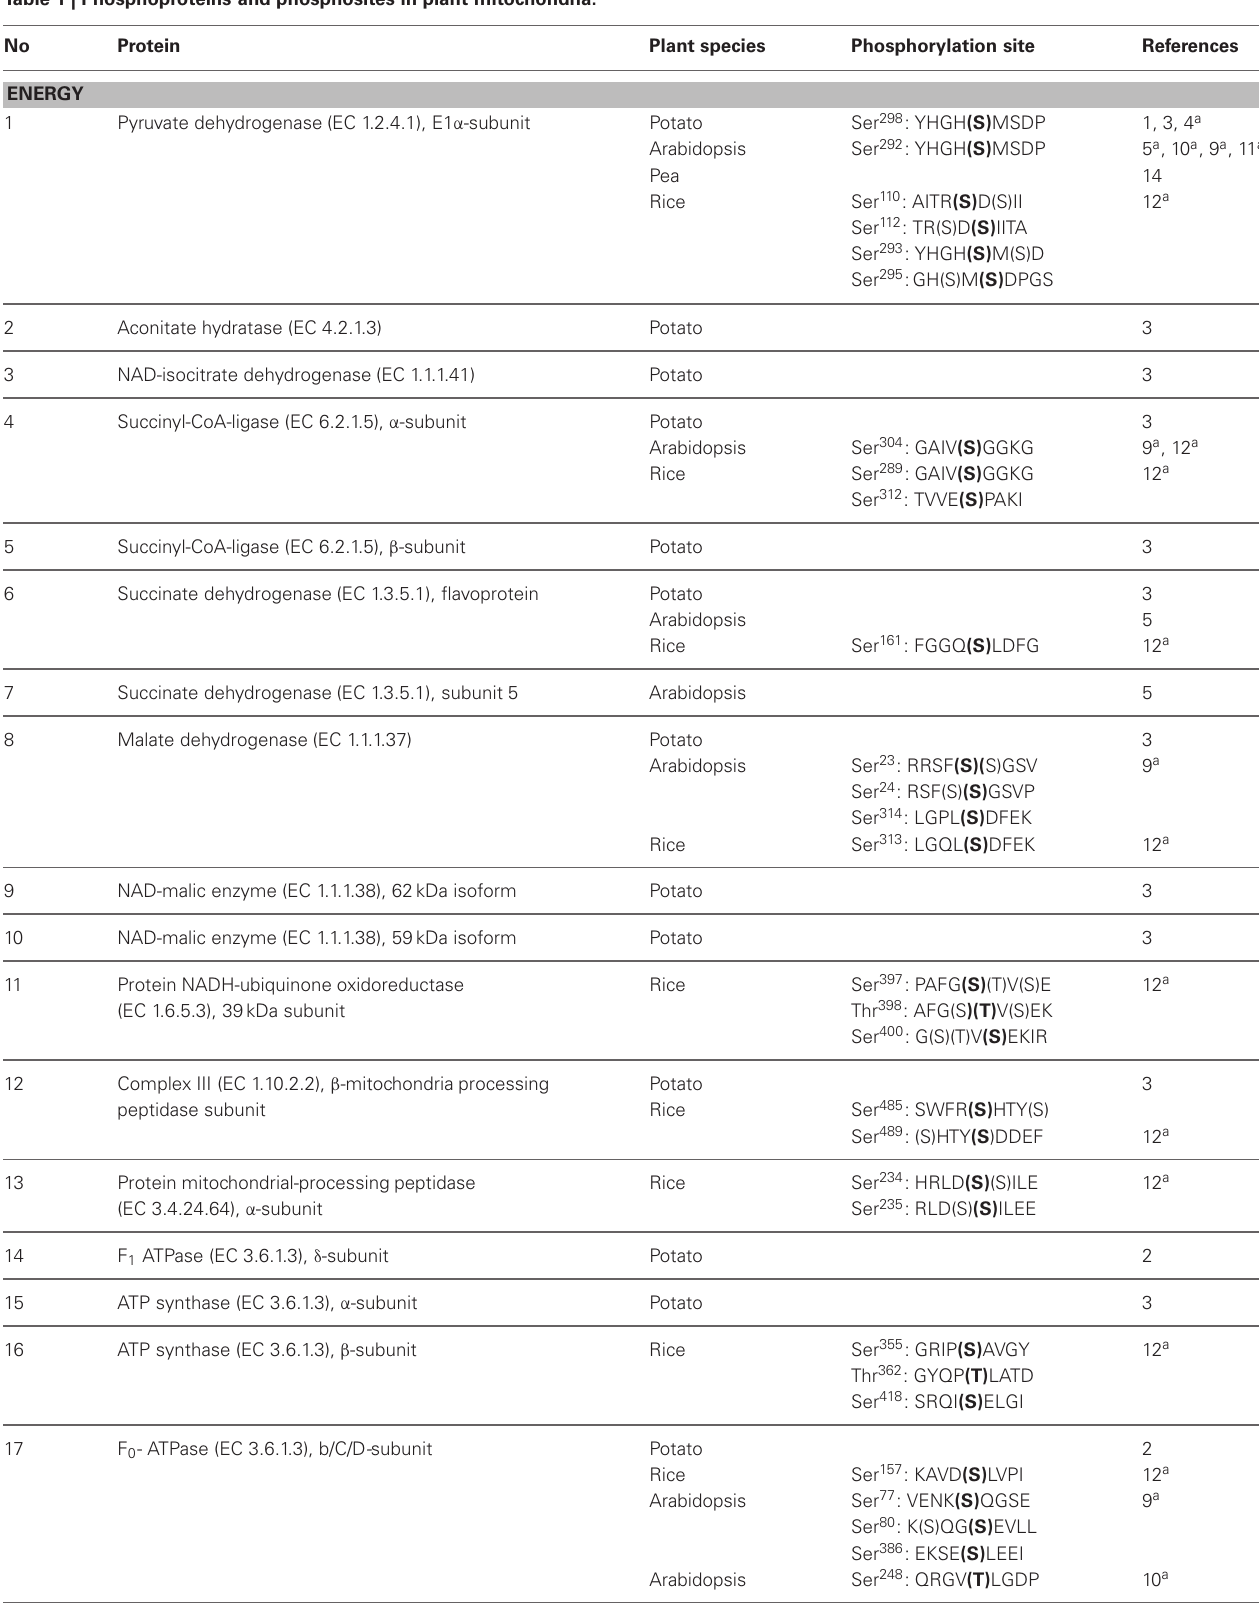
Table 1 | Phosphoproteins and phosphosites in plant mitochondria. Protein Plant